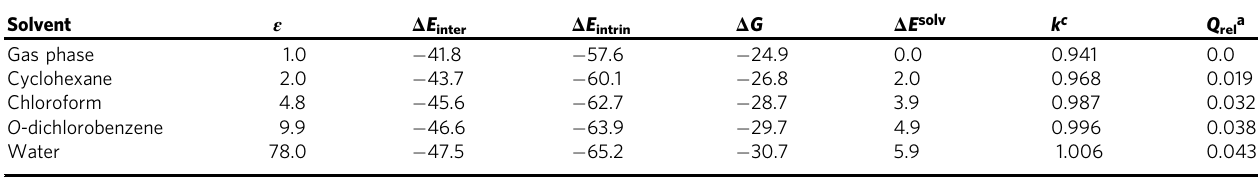
Table 3 The interaction energies ( Δ E inter , kcal/mol), thermodynamics characteristics ( Δ G , kcal/mol), differences in the solvation energies ( Δ E solv , kcal/mol), intrinsic energies ( Δ E intrin , kcal/mol), force constants ( k c , mDyne/Å), and the relative charge transfer ( Q rel ) of Me 3 NBH 3 in various